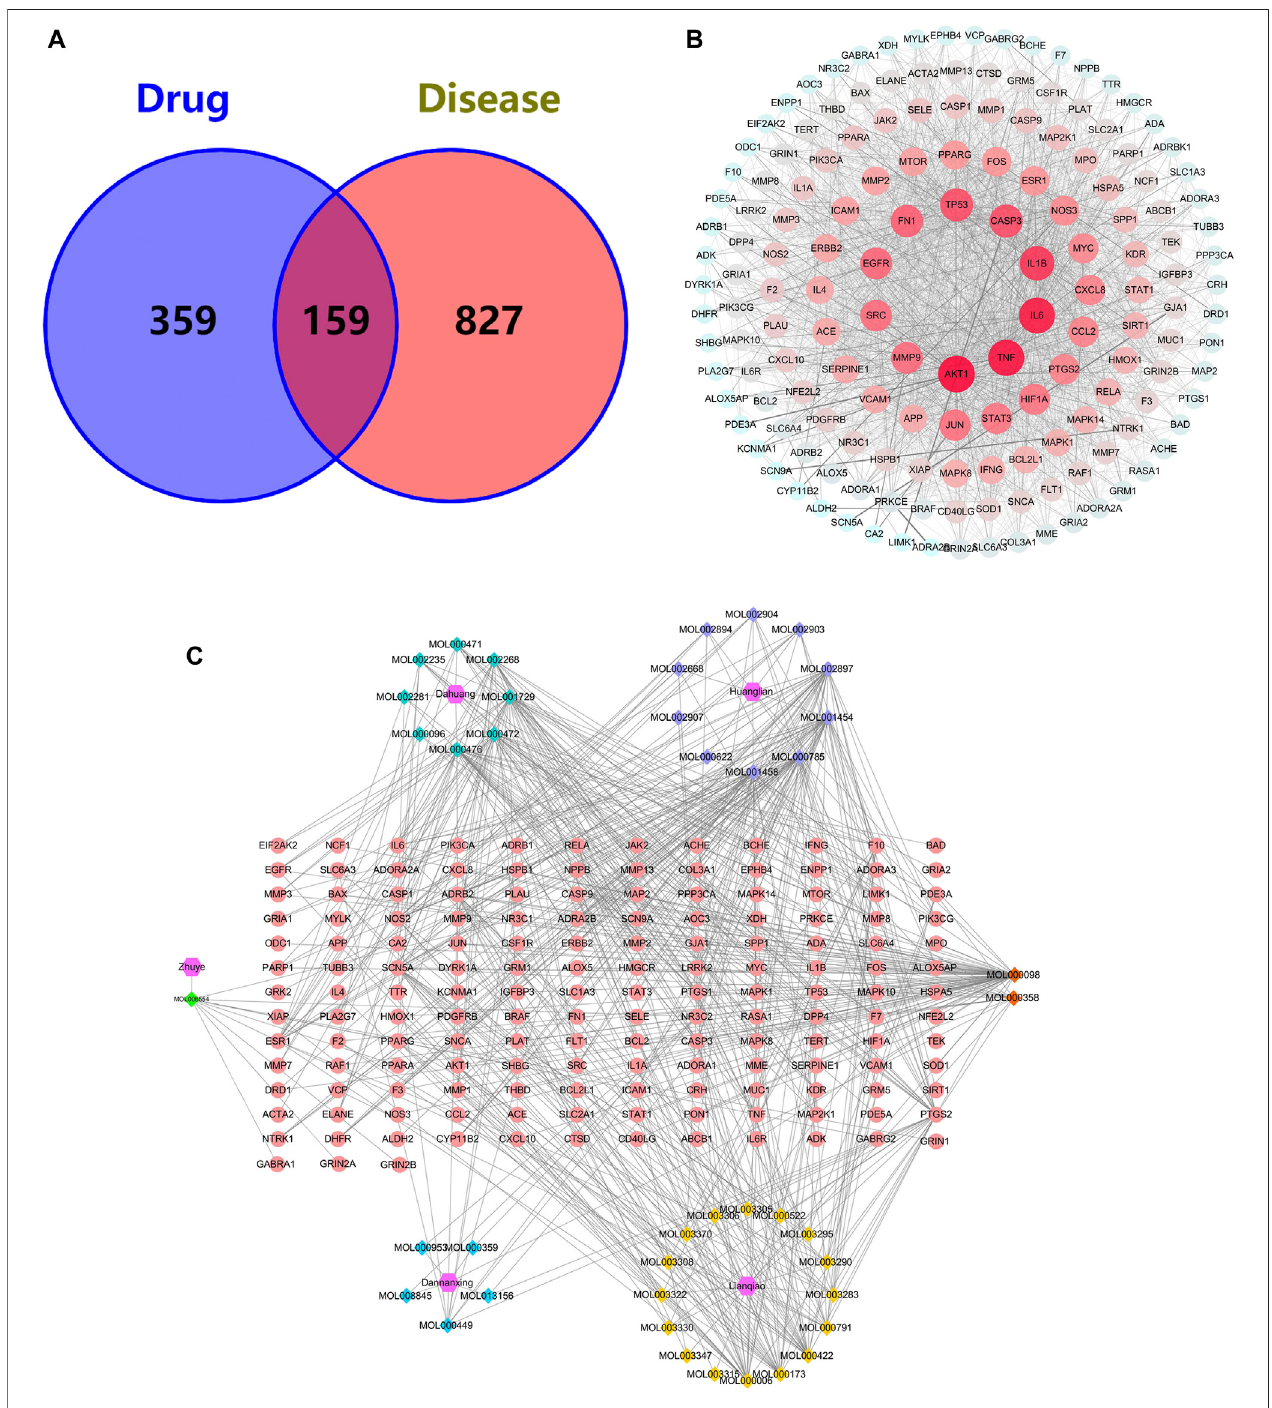
FIGURE 3 | (A) Venn diagram for common genes of THF and AIS. (B) PPI network of the potential targets of THF. (C) Compound – target network of THF on AIS. The regular hexagon, rhombus, and ellipse represent the herbs, herb compounds, and genes, respectively. The number of connected lines indicates the importance of the